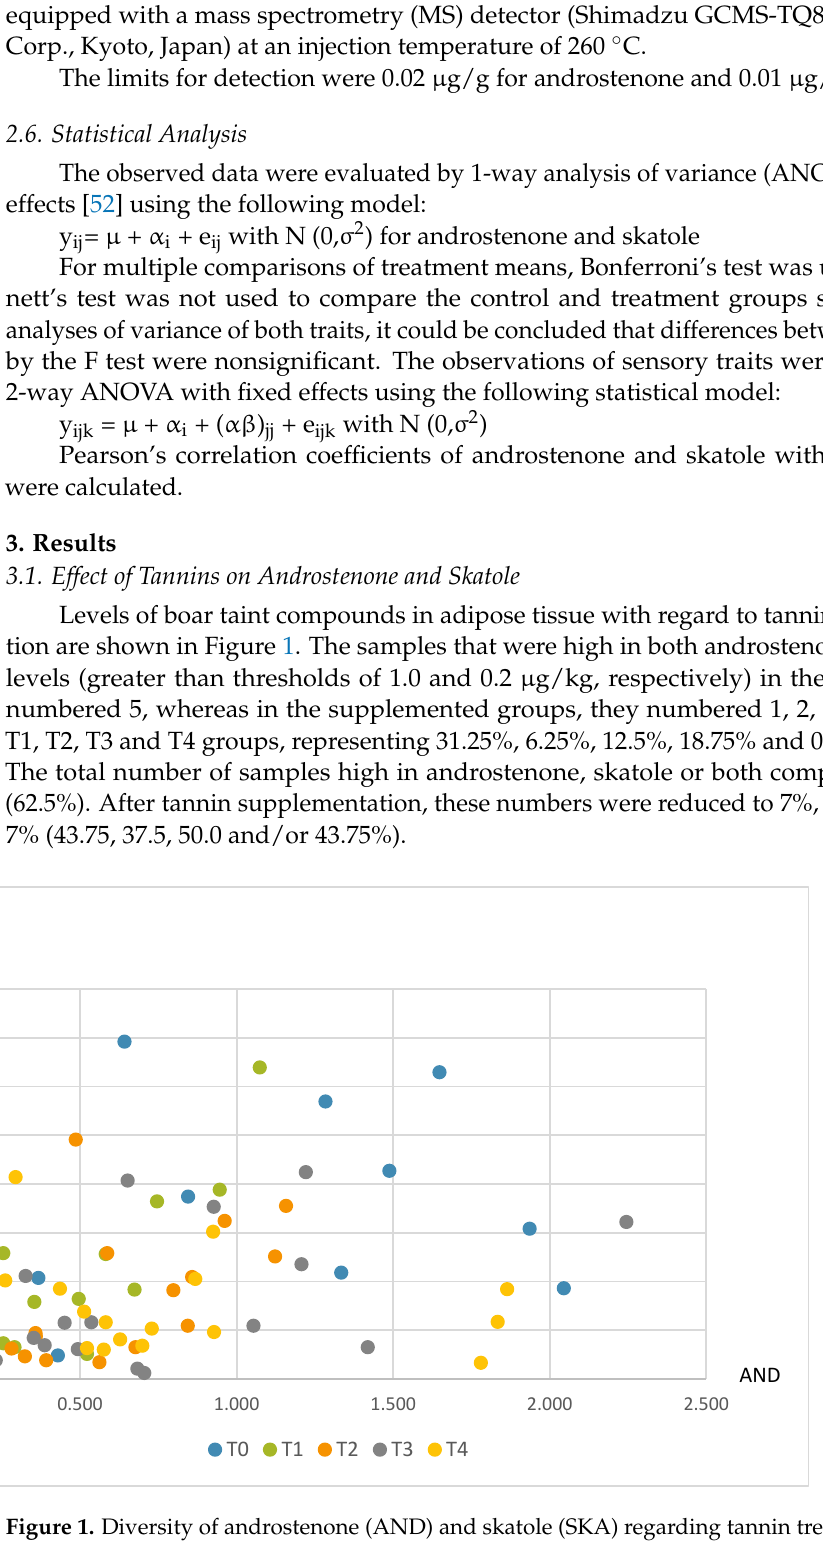
Table 3. Effect of tannin supplementation on androstenone and skatole accumulation in fatty tissue. Trait